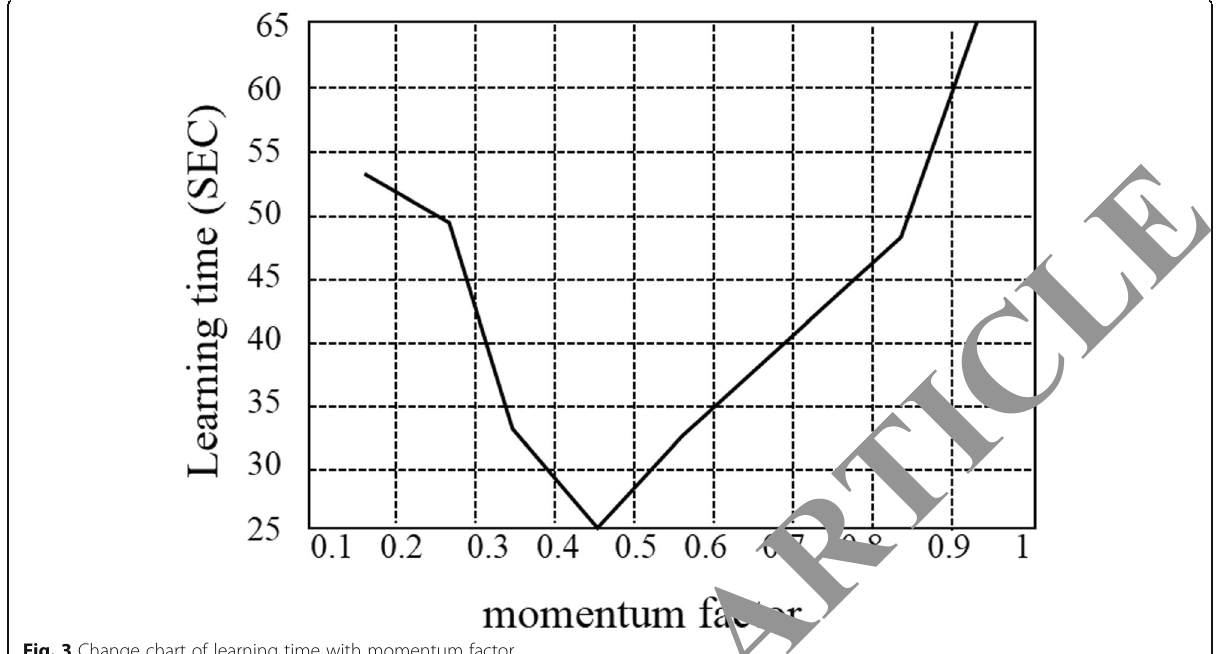
Fig. 3 Change chart of learning time with momentum